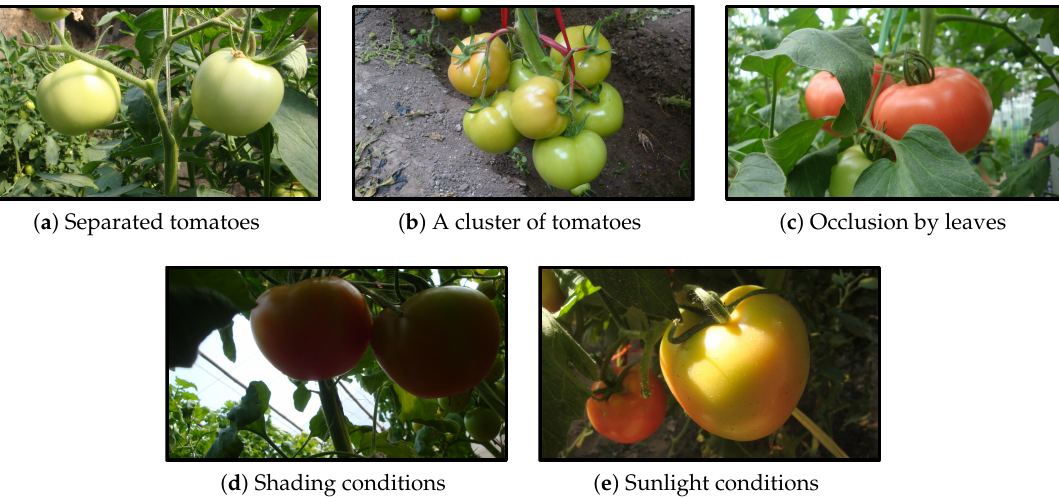
Figure 3. Tomato samples with different growing circumstances: ( a ) two separated tomato, ( b ) a cluster of tomatoes, ( c ) occlusion case, ( d ) shading conditions, and ( e ) sunlight